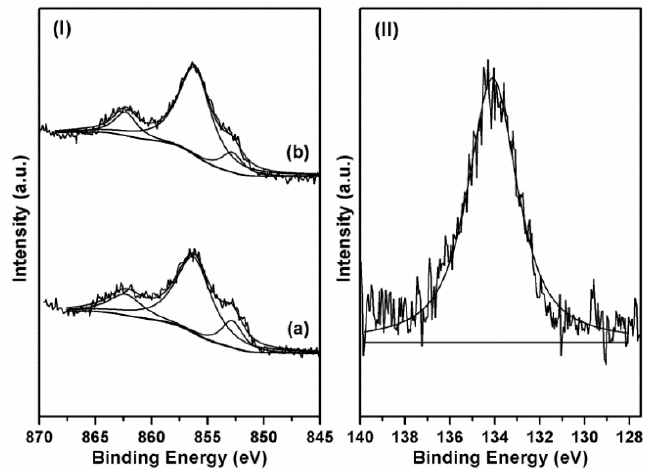
Figure 3. XPS spectra of ( I ) Ni 2p 3/2 levels for 17.5% Ni/Al 2 O 3 -500 ( a ) and 17.5% Ni-4.4% P/Al 2 O 3 -500 ( b ); and ( II ) P 2p levels for 17.5% Ni-4.4% P/Al 2 O 3